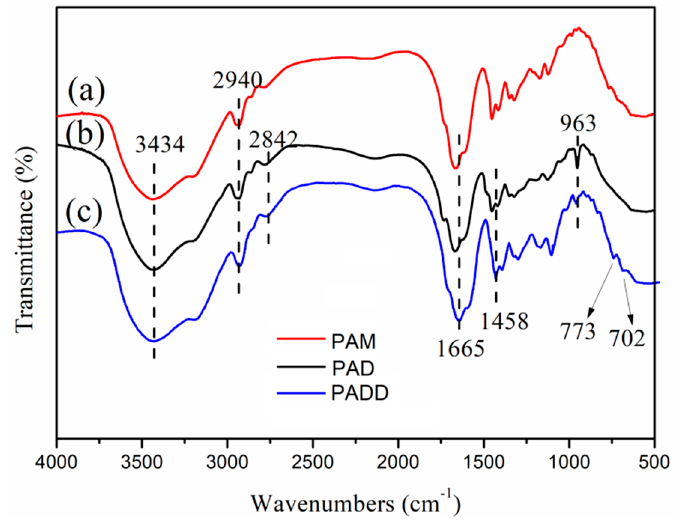
Figure 3. The FTIR of ( a ) PAM, ( b ) PAD, and ( c ) PADD.